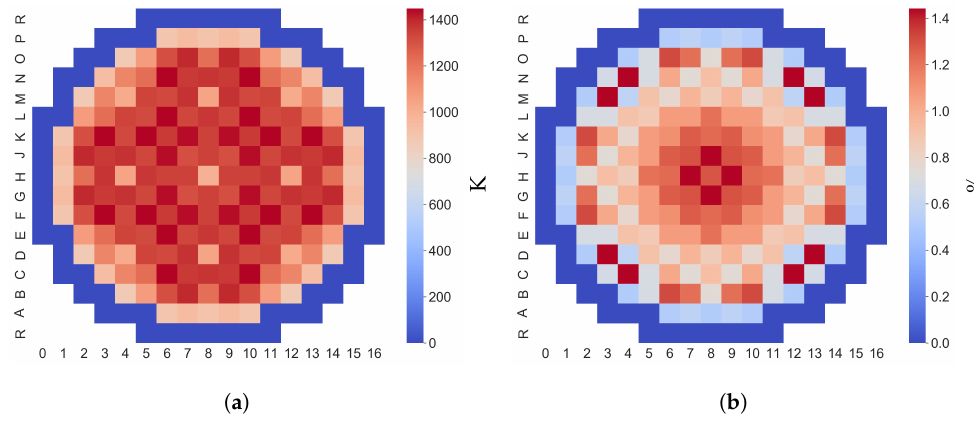
Figure 31. Radial profile of T ave